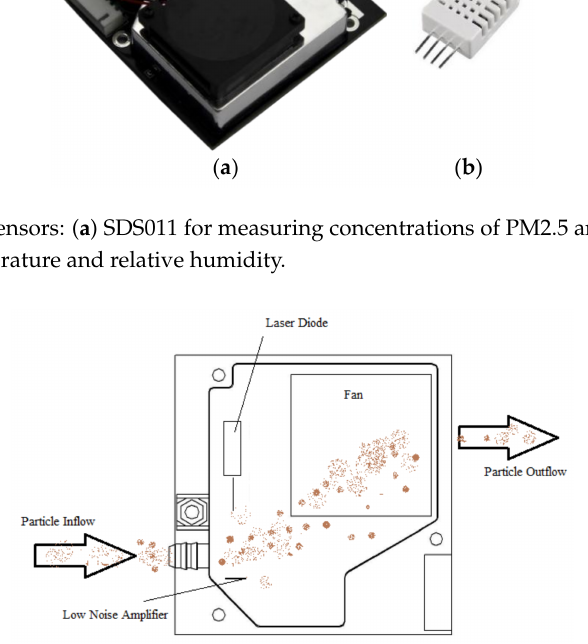
Figure 2. Layout of SDS011 sensor for measuring particulate matter (PM) concentrations. Particles flow through the sampling inlet and enter the sensing chamber, where the incident laser beam is scattered depending on their size. A low noise amplifier operates as a transducer, by transforming the collected light to various signal